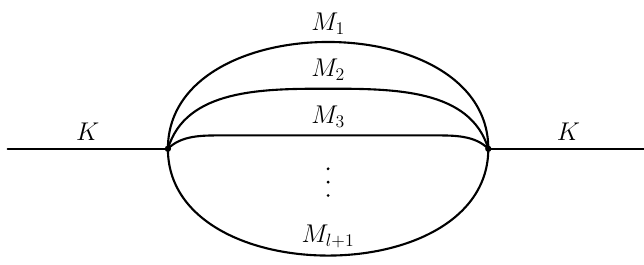
Figure 1 . The l -loop banana diagram with external momentum K and internal masses M i .